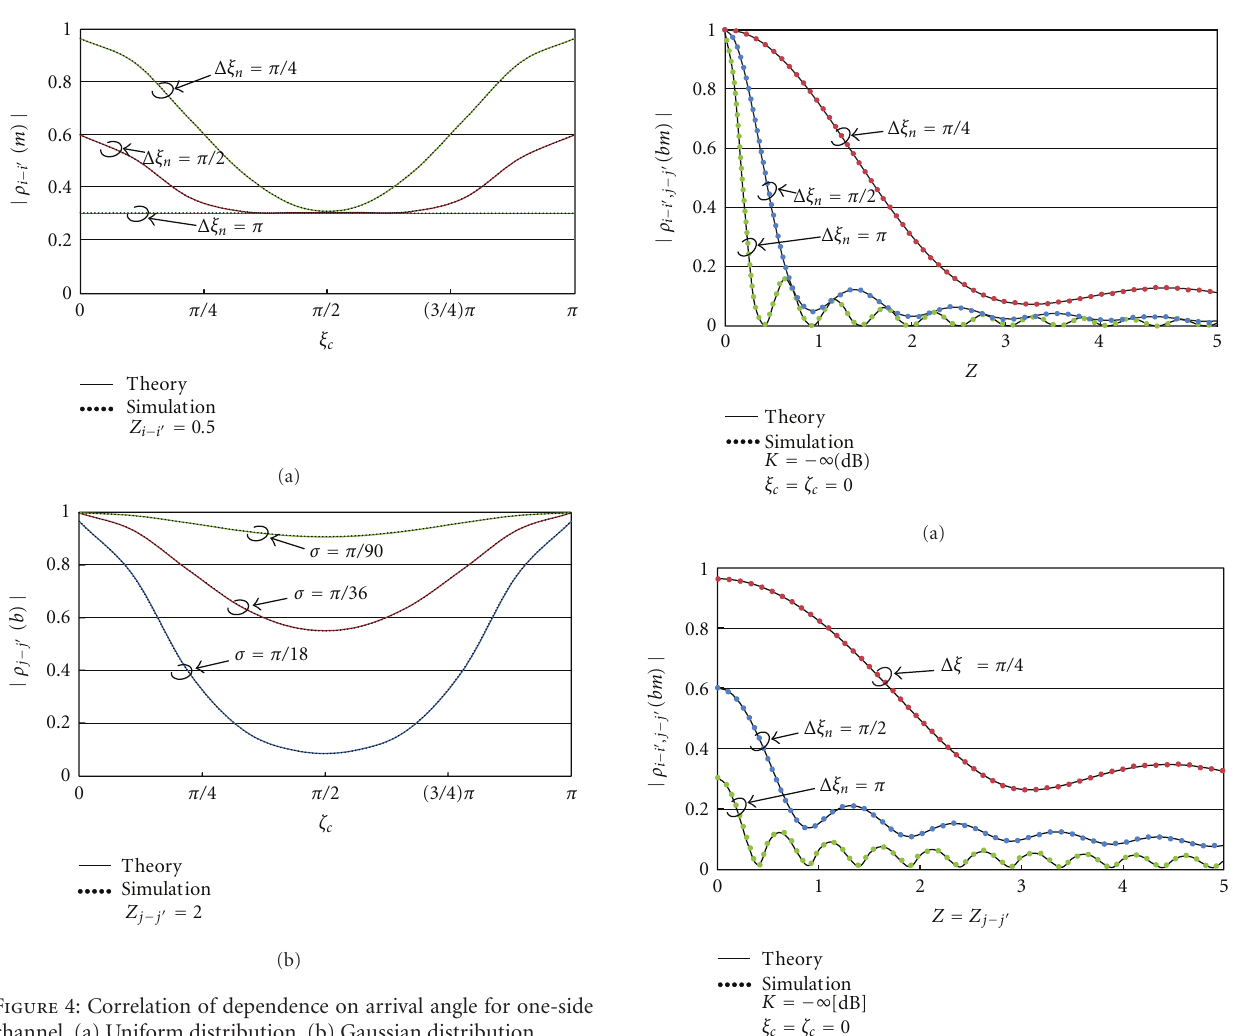
from (10) is the product of ρ i − i (cid:2) ( m ) and ρ j − j (cid:2) ( b ), or here bm ) | = | ρ m ) | 2 . The simulated and theoretical | ρ i i − i (cid:2) ( − j , i (cid:2) − j (cid:2) (